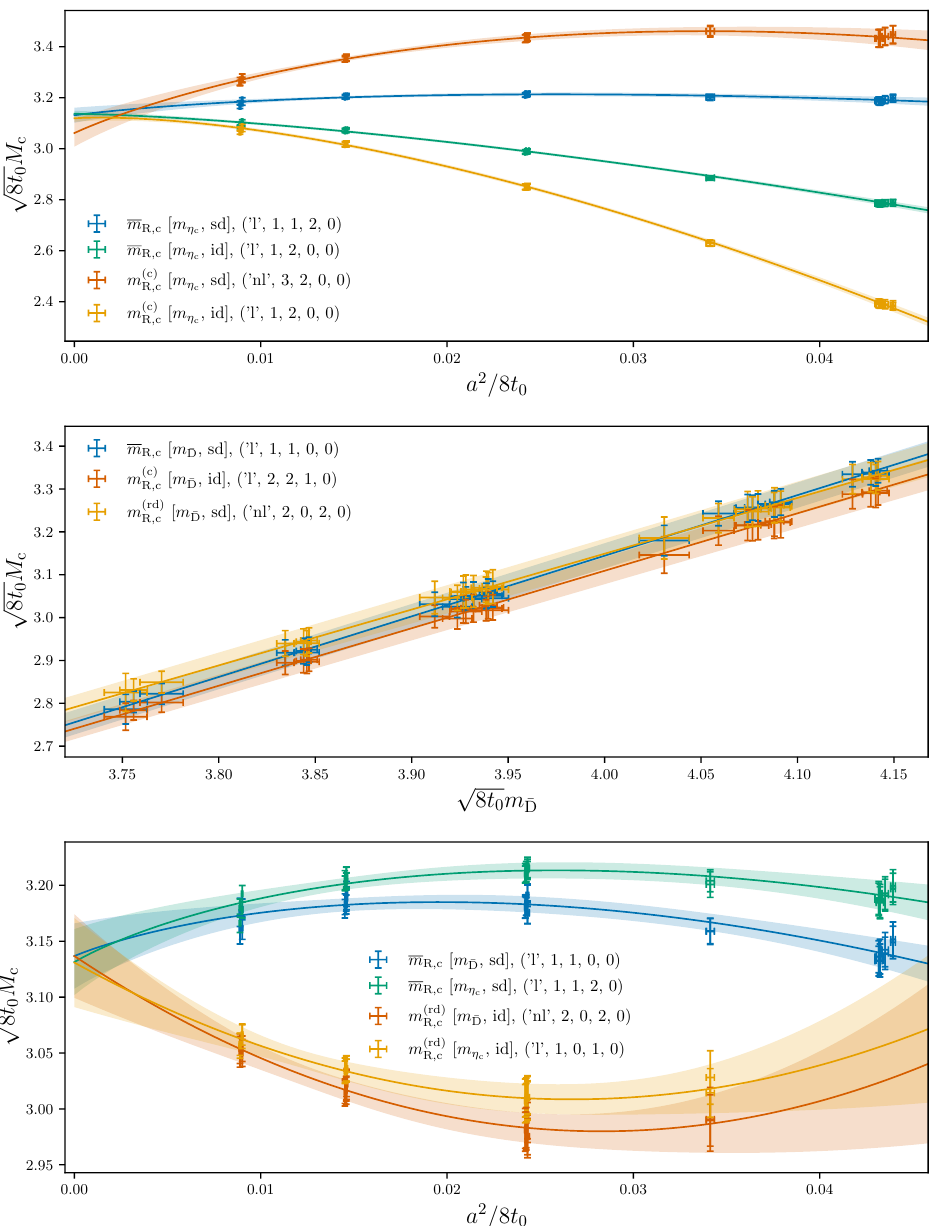
Figure 2 . Comparison of best fits according to the AIC in different categories. To map out two- dimensional representations of the fits, other dependencies than the ones illustrated in the plots have been projected to the physical point. The top panel reproduces the influence of utilising standard versus improved lattice derivatives to extract bare PCAC quark masses, while the middle one exhibits the clearly linear dependence of the charm quark mass estimators on the dimensionless √ heavy meson mass, φ = 8 t , in case of m = m . The bottom panel reflects the sensitivity ¯D H 0 m H H of the joint global extrapolation results to the choice of φ for fixing the physical charm point. The H labelling convention as well as further details are given in the